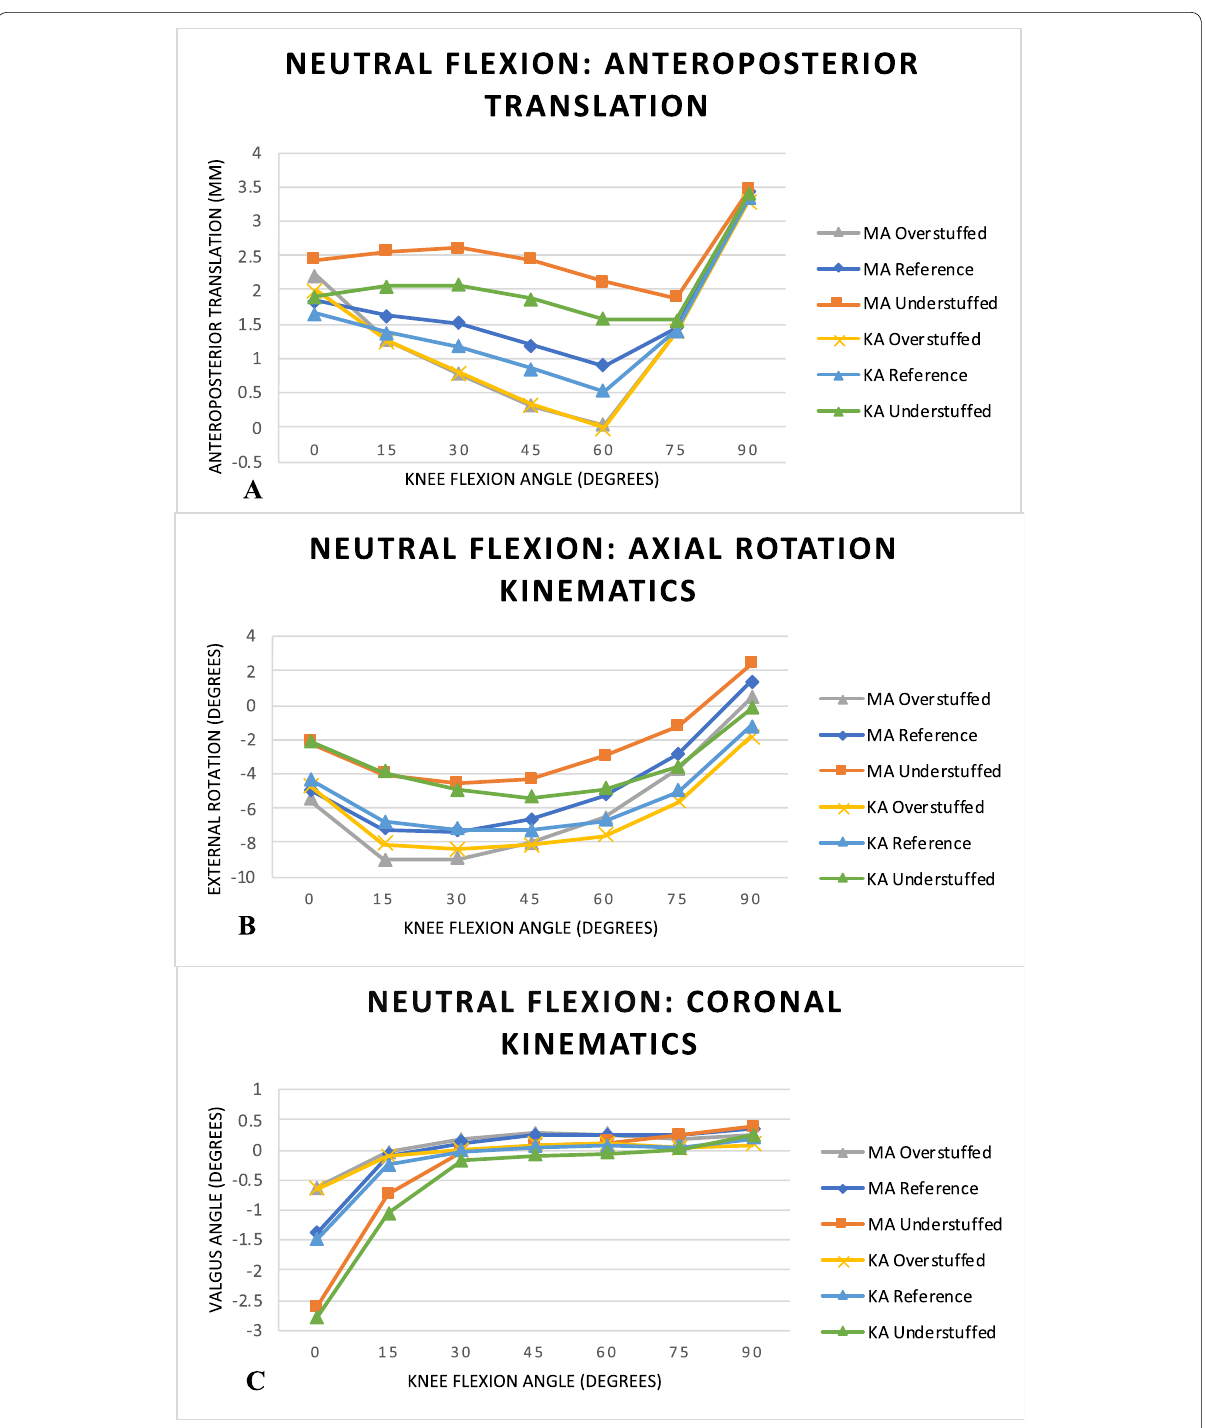
Fig. 3 Graphs demonstrating the neutral flexion kinematics. A Anteroposterior, B Axial Rotation, C